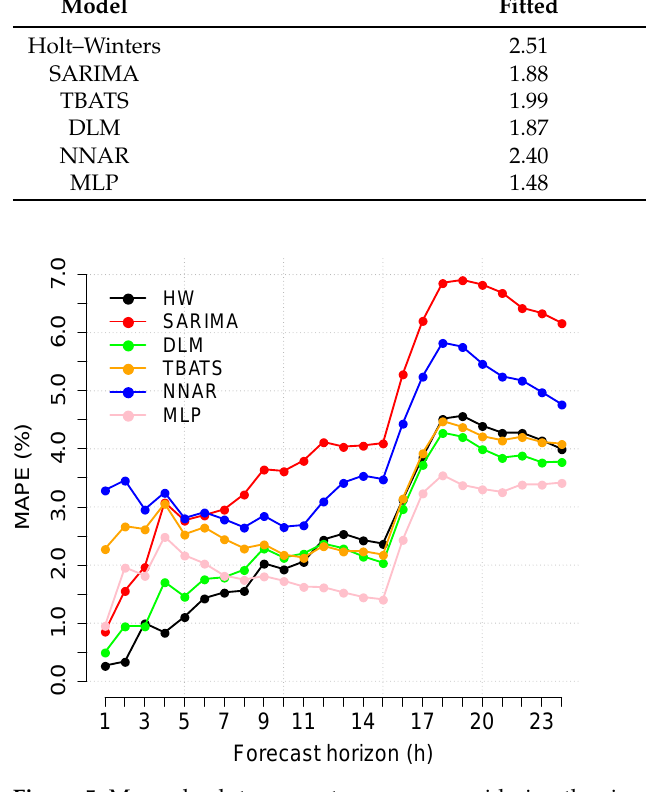
Figure 5. Mean absolute percentage error, considering the six models, for h = 1,...,24 steps-ahead out-of-sample forecasts applied to the electricity consumption of the Brazilian